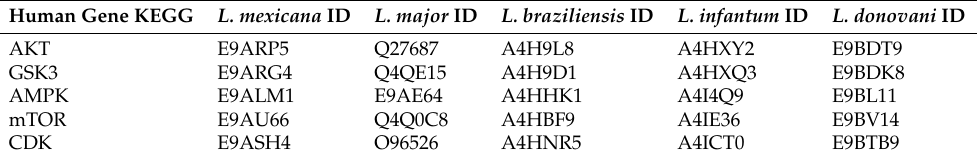
Table 1. List of kinases present in the human PI3K/AKT pathway with potential orthologues (UniProtKB IDs) in different Leishmania species.